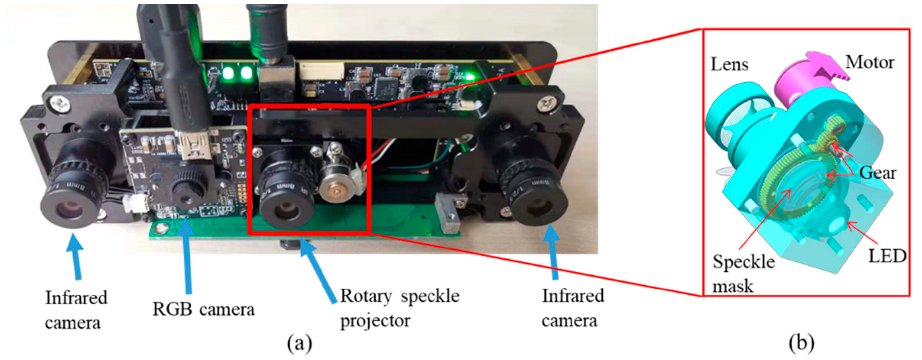
Figure 7. ( a ) Three-dimensional face acquisition equipment with rotary speckle projector. ( b ) Internal structure diagram of rotating speckle projector .